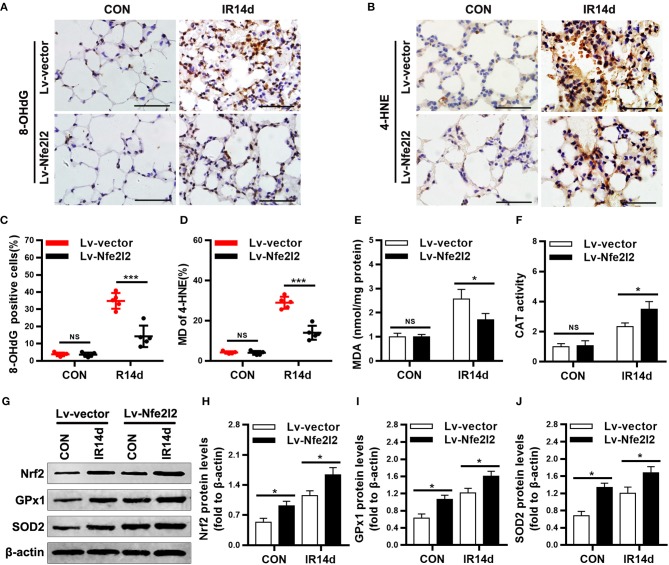
Excess Nrf2 attenuates radiation-induced oxidative damage in lung tissues. (A,C) Nrf2 overexpression decreased 8-OHdG positive cells in lung tissues as measured by immunohistochemistry staining. (B,D) Nrf2 overexpression decreased 4-HNE positive cells in lung tissues. (E) Levels of MDA in lung tissues were lower in Nrf2-overexpression mice compared with vector-control mice. (F) CAT activity in lung tissues was higer in Nrf2-overexpression mice compared with vector-control mice. (G–J) Excess Nrf2 upregulated the protein levels of Nrf2, GPx1, and SOD2 in lung tissues as measured by Western blot. Scale bar: 50 μm. n = 5. NSRepresents no statistical difference (P > 0.05). *P < 0.05; ***P < 0.001. Every experiment was repeated for 3 times. The data was shown as mean ±SD and the representative figures were presented here.